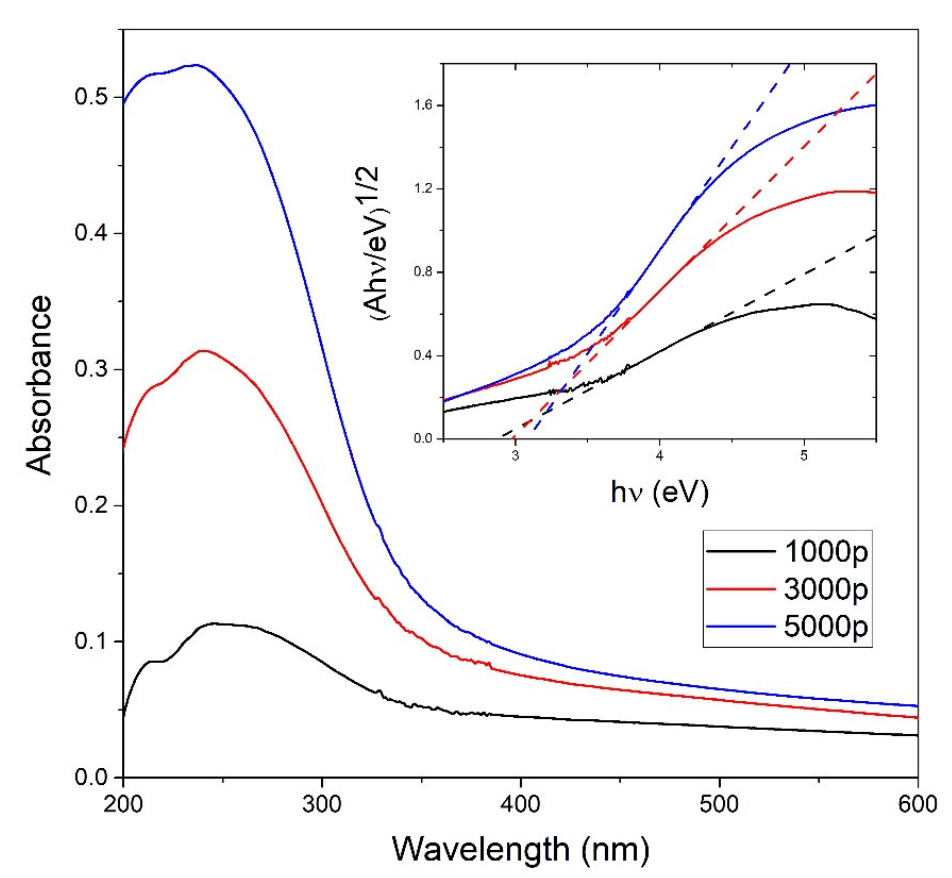
Figure 4. Photoabsorbance vs. wavelength measurements on TiO 2 colloidal solutions dependent on the number of pulses; Inset: indirect TiO 2 bandgap calculation from the Tauc plot for different colloidal TiO 2 NP solutions using the photoabsorbance data.